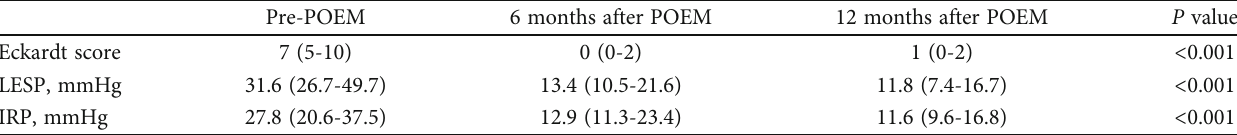
Table 3: Eckardt score, LESP, and IRP data pre- and postoperative POEM.